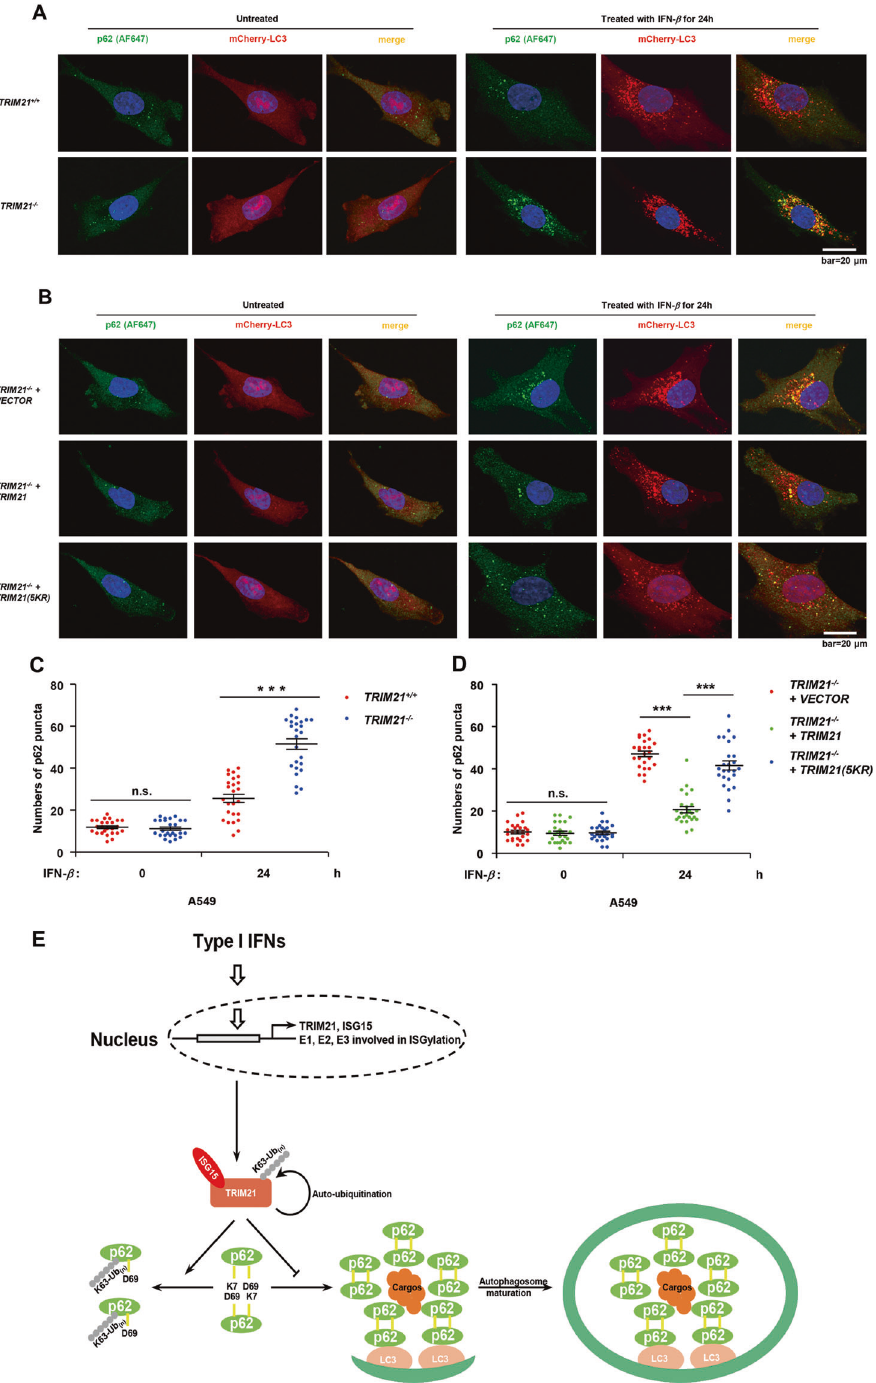
Fig. 6 IFN- β -induced TRIM21 ISGylation prevents p62 oligomerization and autophagosome targeting. A TRIM21 + / + and TRIM21 − / − A549 cells were untreated or treated with IFN- β for 24 h. Cells were fi xed, permeabilized, and then subjected to staining with anti-p62 antibody (green). Co-localization of p62 puncta and mCherry-LC3 labeled autophagosomes (red) were observed under Andor Dragon fl y turntable confocal microscope. B TRIM21 − / − A549 cells stably expressing VECTOR, TRIM21, or TRIM21(5KR) mutant were untreated or treated with IFN- β for 24 h. Cells were subjected to staining with anti-p62 antibody and observed under confocal microscope as A . C , D p62 puncta in TRIM21 + / + and TRIM21 − / − A549 cells ( C ) or TRIM21 − / − A549 cells stably expressing VECTOR, TRIM21, or TRIM21(5KR) mutant ( D ) untreated or treated with IFN- β for 24 h were quanti fi ed with Imaris. Data shown were the statistical result of 25 cells for each cell line in 28 independent experiments plotted with GraphPad Prism 5. Data were analyzed with Student ’ s t test and represented as mean ± standard error of the mean (n.s. not signi fi cant. *** P < 0.001). E A working model for regulation of p62 self-oligomerization and autophagosome targeting by TRIM21 ISGylation. Induction of TRIM21 ISGylation by IFN- β activates TRIM21 to catalyze K63-linked ubiquitination of itself and p62, which results in blocking of p62 self-oligomerization and subsequent localizing to autophagosome formation